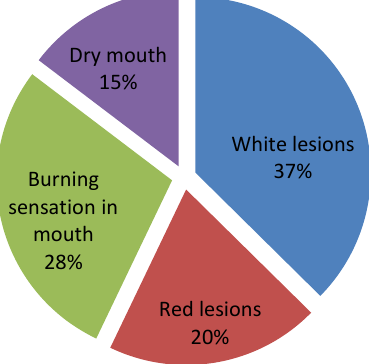
Figure 4. Pie chart of answers related to knowledge of features of OSCC.